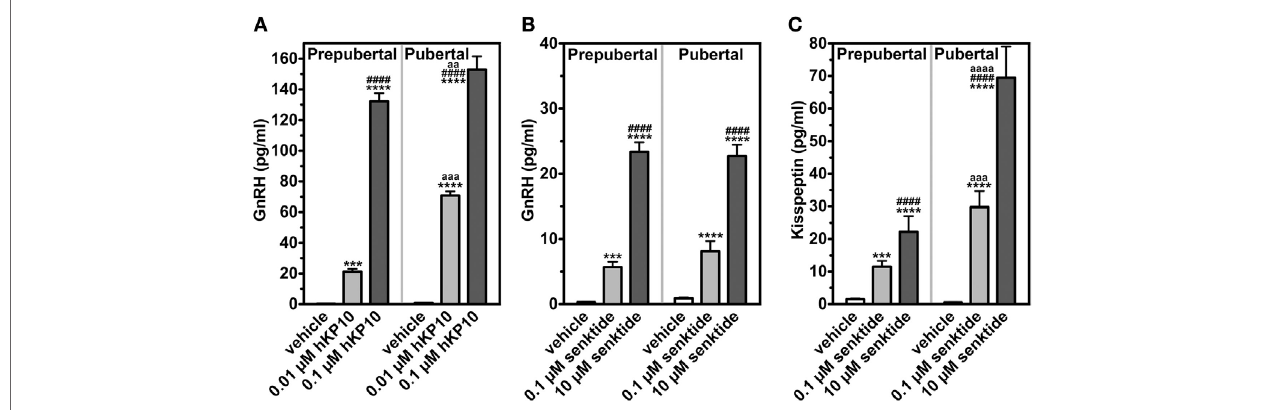
FiGURe 2 | Changes in release of GnRH and kisspeptin (area under the curve in response to challenge of secretagogues). GnRH in response to human kisspeptin-10 (hKP10) (A) and senktide (B) in female rhesus monkeys are shown. Kisspeptin response to senktide (C) is also shown. *** p < 0.001; **** p < 0.0001 vs. vehicle control (within a group). #### p < 0.0001 vs. lower dose (within a group). aa: p < 0.01; aaa: p < 0.001; aaaa: p < 0.0001 vs. prepubertal stage (between groups at the same dose of challenge). Modified from Ref. (35) with data from Ref. (34) with Copyright